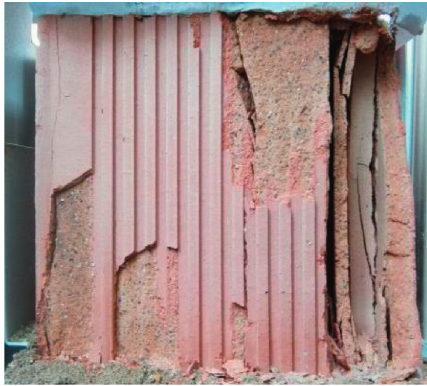
Figure 2: Failure phenomena of fired shale hollow Table 2: The compressive strength of fired shale hollow block.